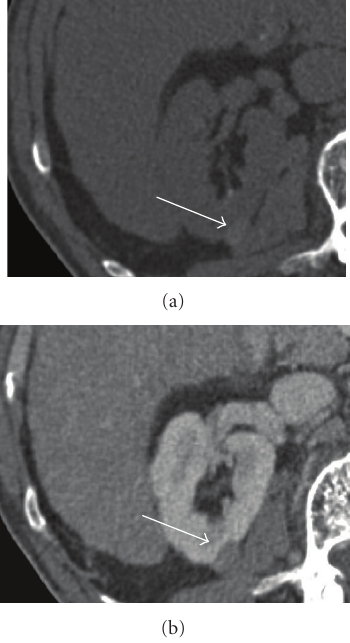
Figure 5: Hemorrhagic cyst. (a) Unenhanced CT scan shows a hyperattenuating small renal mass (62H) (arrow). (b) Contrast- enhanced CT scan during the nephrographic phase reveals light enhancing (attenuation value increased 9H:71 H)